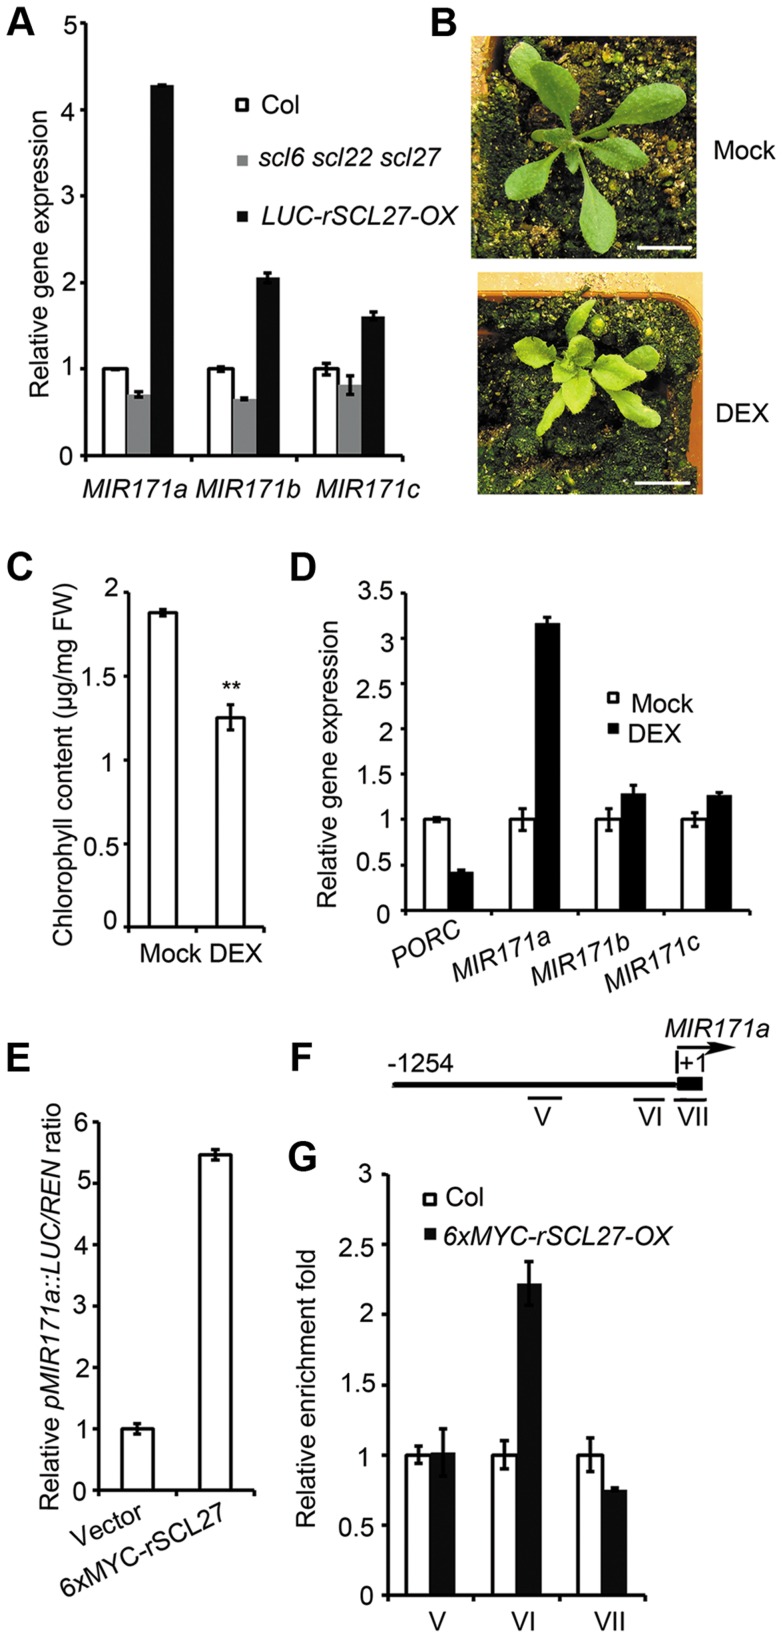
SCL27 activates MIR171 gene expression in a feedback manner.(A) qPCR analysis of MIR171a, MIR171b and MIR171c expression in Col, scl6 scl22 scl27 and LUC-rSCL27-OX plants. Relative expression levels of MIR171 genes were normalized to that of ACTIN2, and the relative expression in WT plants was set as 1. Error bars represent the s.d. (n = 3). Two biological replicates were performed with similar results. (B) 35S::6xMYC-rSCL27-GR/scl6 scl22 scl27 transgenic plants were treated with DEX (10 µM) or untreated (Mock) for 20 days. Bars = 1 cm. (C) Chlorophyll content of the plants shown in (B). ** indicates p value (Student's t-test) <0.01; Error bars indicate the s.d. (n = 4). (D) Relative expression of PORC, MIR171a, MIR171b and MIR171c in the plants shown in (B). Expression levels were normalized to that of ACTIN2. Expression levels in plants without DEX were set as 1 for each gene. Error bars represent the s.d. (n = 3). Two biological replicates were performed with similar results. (E) Relative activity of the MIR171a promoter. pMIR171a::LUC was transformed into N. benthamiana leaves with or without co-transformation of 6xMYC-rSCL27. Relative LUC activities were normalized to the 35S::REN internal control. Error bars indicate the s.d. (n = 4). Three biological replicates showed similar results. (F) Schematic diagram of MIR171a promoter regions V (−726 bp to −495 bp), VΙ (−260 bp to −71 bp) and VΙΙ (the precursor of MIR171a), which were used for ChIP experiments. (G) Relative enrichment of MIR171a promoter fragments in the immuno-precipitates. Leaves of 3-week-old Col and 6xMYC-rSCL27-OX plants were used for ChIP experiments. The enriched DNA fragments were quantified using qPCR. The β-TUBULIN-2 promoter was used as a reference. Error bars indicate the s.d. (n = 3). Similar results were obtained from three independent immuno-precipitation experiments.